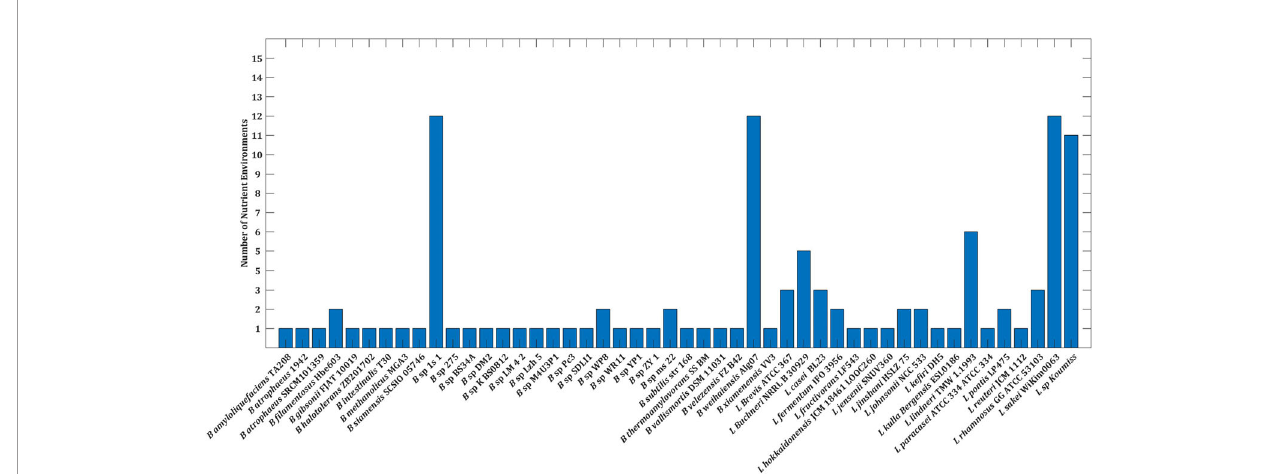
FIGURE 2 | Barplot depicting the number of nutrient environments in which strains limits growth of V. harveyi .